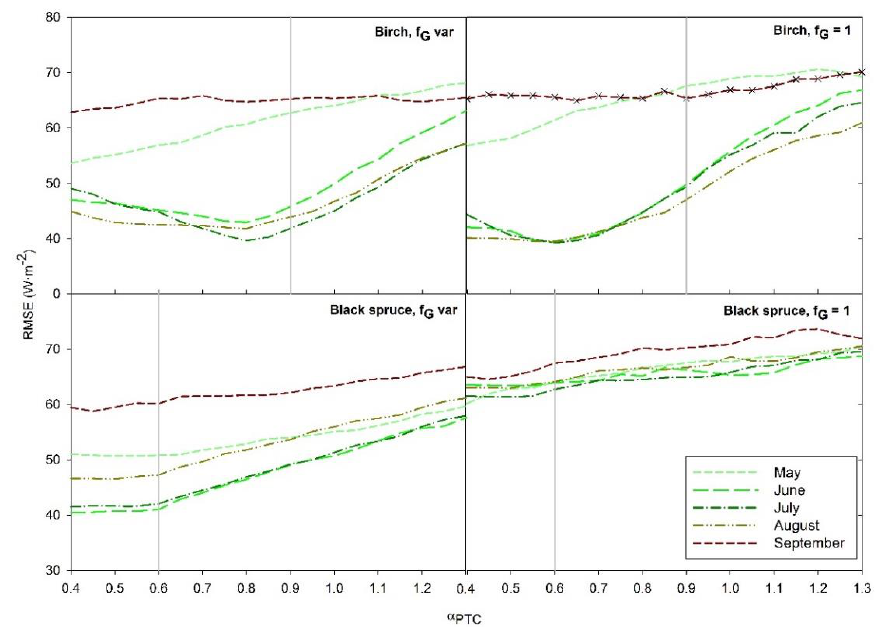
Figure 6. Sensitivity analysis on LE estimation running TSEB with α PTC increasing in value at an interval of 0.05 from 0.4 to 1.3 for both black spruce and birch, respectively, with (a) a variable f G derived from the EVI and NDVI ratio and (b) a f G = 1. RMSE results were monthly averaged from May to September for the 2012–2016 period. Vertical grey lines are the reference adjusted α PTC values used in TSEB to model LE for black spruce and birch.